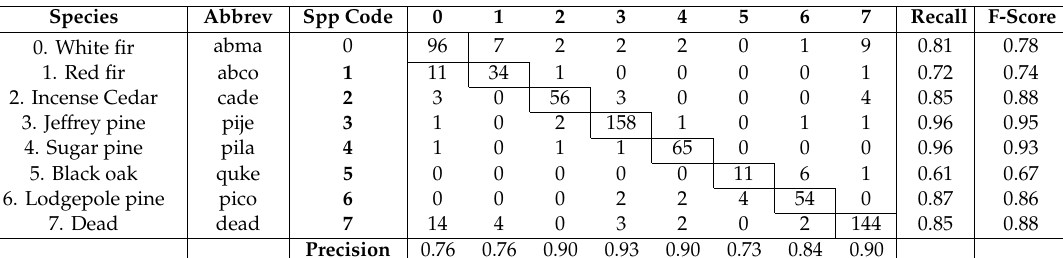
Table 3. The hyperspectral classification confusion matrix for tree species identified using high-precision field GPS (rows) compared to the CNN model species prediction (columns; numbered labels refer to species numbers shown in row labels).